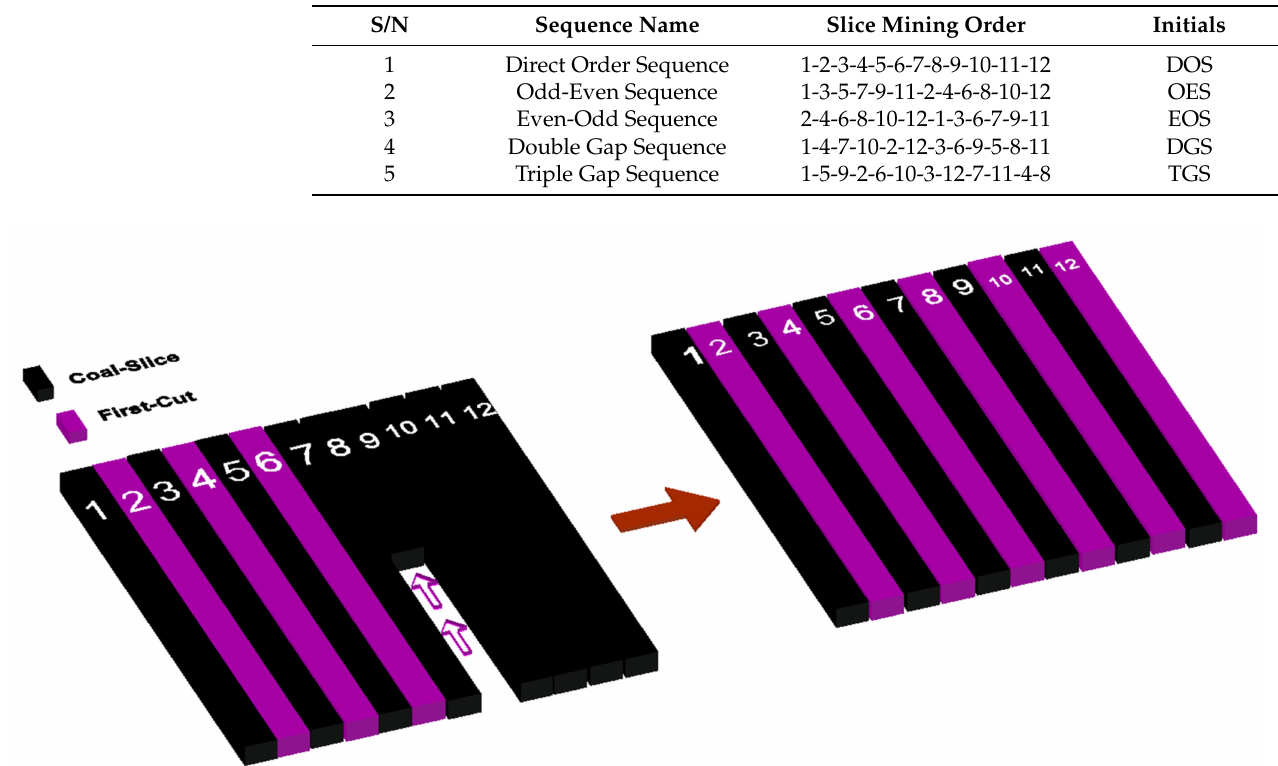
Table 4. Slice mining sequence variation.